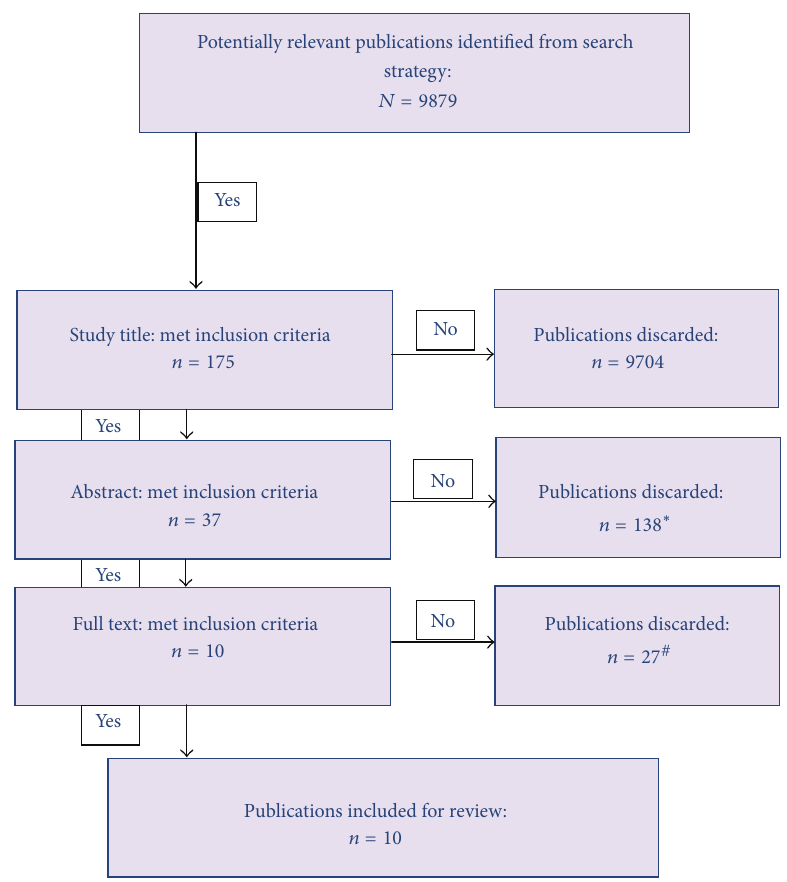
Figure 1: The PRISMA flowchart. ∗ Papers were secondary studies or primary studies with focus on obesity, obesity paradox, or mortality but not a relationship between them. # Papers used nonstandard categories of BMI classification and other measures of body fat composition or used composite